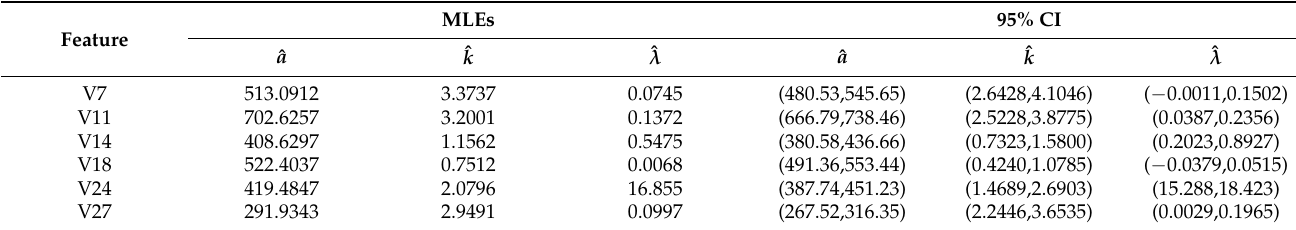
Table 4. MLEs and 95% CIs of the MPoW parameters.